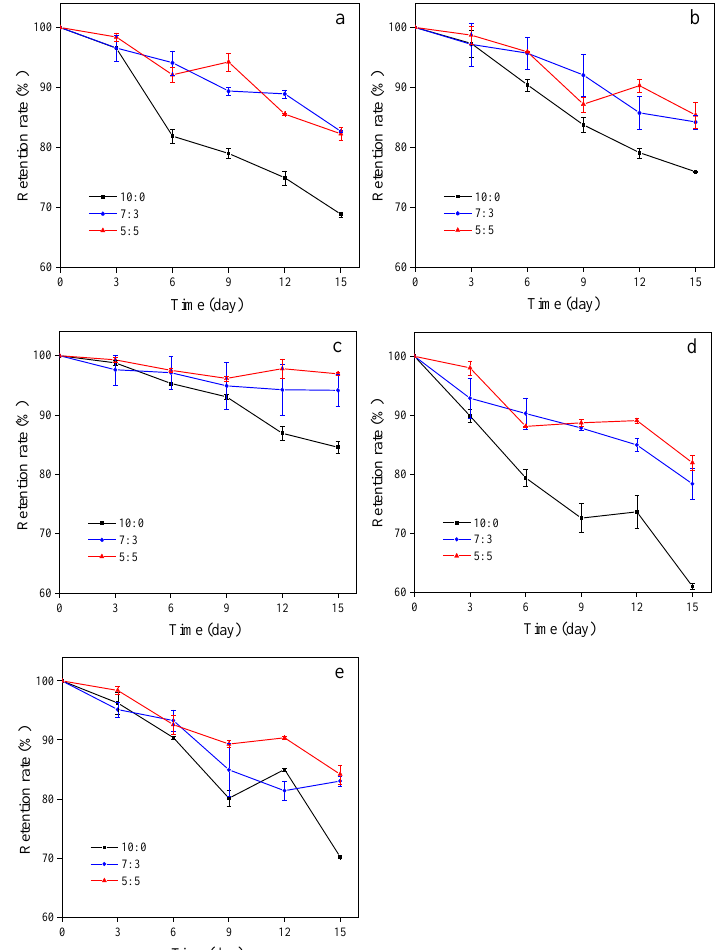
Figure 6. Retention rate of sodium caseinate-acetylated mung bean starch–lutein microcapsules under different storage conditions (( a ), 50 ◦ C in the dark; ( b ), 25 ◦ C in the dark; ( c ), 4 ◦ C in the dark; ( d ), UV light at room temperature; ( e ), lightness at room temperature). 10:0, 7:3, and 5:5, respectively, represent the weight ratio of sodium caseinate and acetylated mung bean starch.